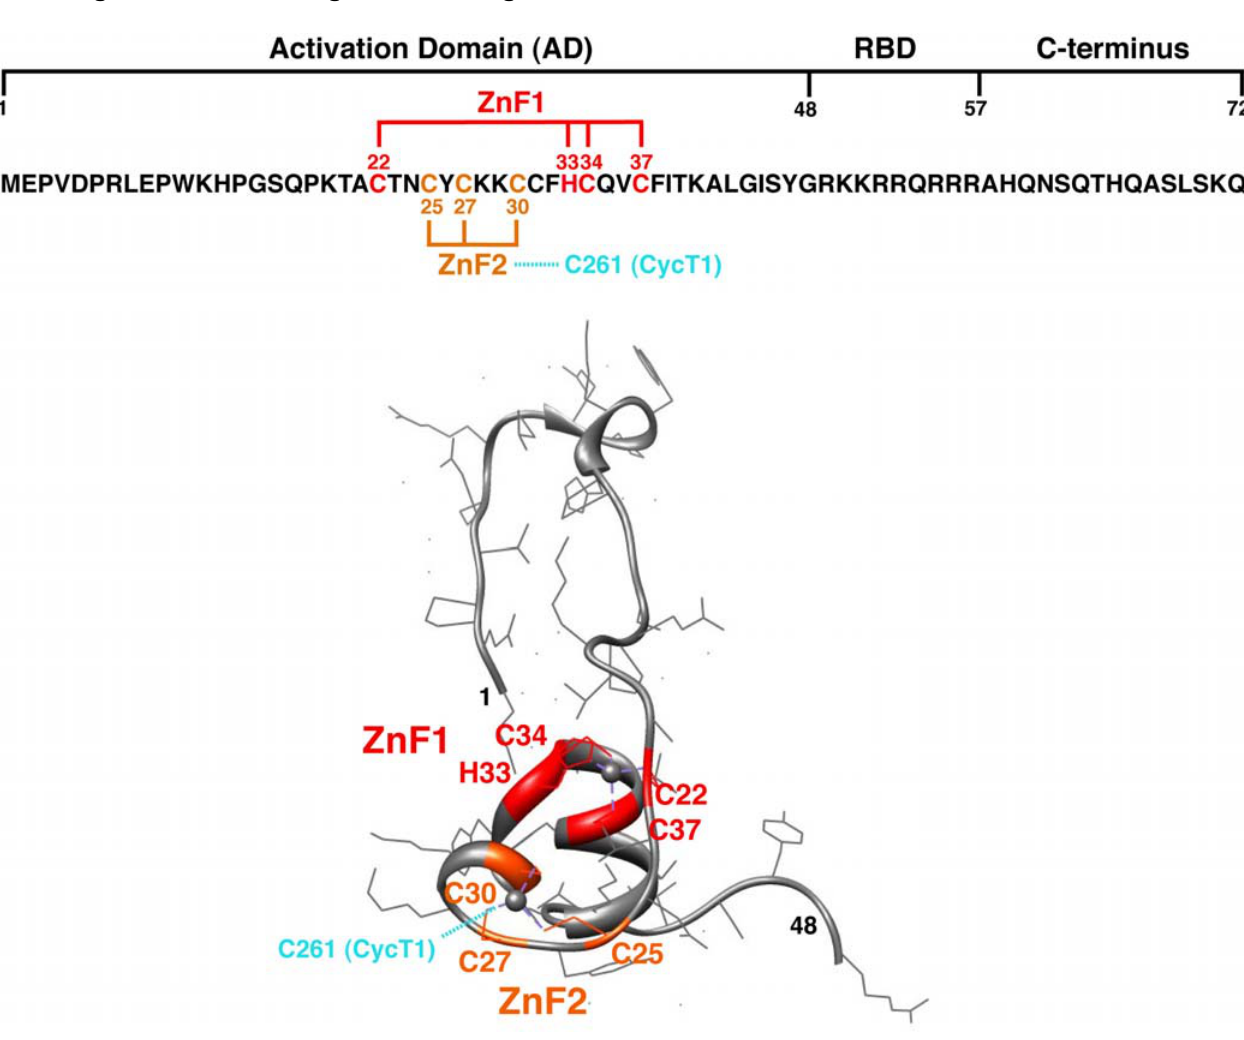
Figure 1. Sequence of Tat and structure of the Tat activation domain (AD) in the context of the Tat:P-TEFb crystal structure. The sequence of Tat exon 1 (residues 1-72) is shown along with its different modules: AD (residues 1-48), RBD (residues 49-57) and C-terminus (residues 58-72). Within the AD, the two Zinc-finger motifs, ZnF1 and ZnF2, are shown in red and orange. The metal coordination of ZnF2 is completed by C261 of CycT1 (cyan). Only the Tat AD is observed in the structure and becomes folded upon the P-TEFb interaction (chain C in PDB 3MI9). The structure representations shown in Figures 1 and 2 were generated using Chimera software